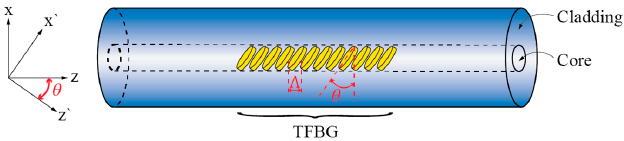
Figure 19. Tilted FBG formation.